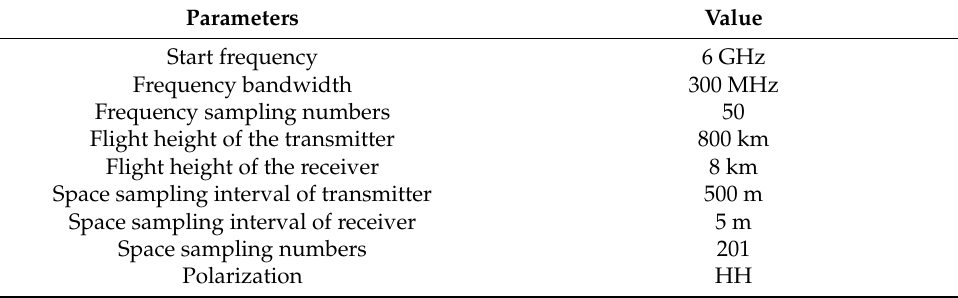
Table 1. Parameters of the observation